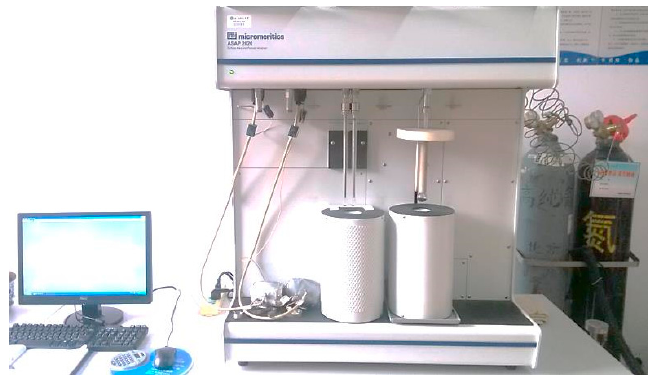
Figure 2. ASAP 2020M automatic analyzer for SSA (specific surface area) and micropores.